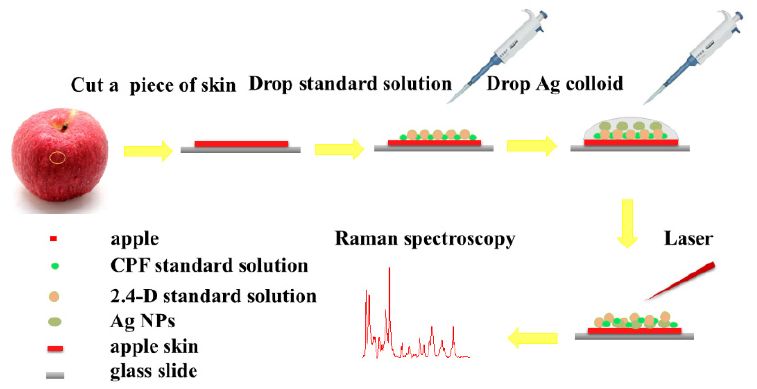
Figure 2. Flowchart of the sample preparation procedure.